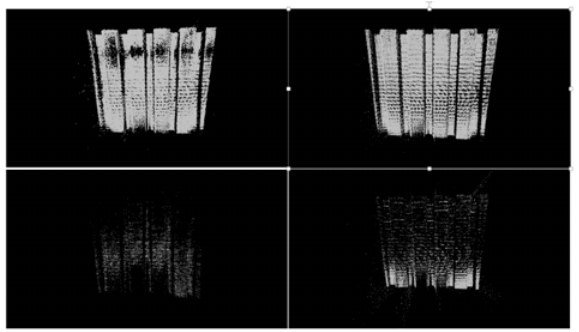
Figure 7: Comparison of point cloud result: conventional gray code (left-top), maximum min-SW gray code (right-top), micro phase shifting code with frequency band around 16 pixels and 5 frequencies (left-bottom), micro phase shifting code with fre- quency bande around 64 pixels and 5 frequencies (right-bottom) The mesh result of the beam is shown in Figure 8. The compari- son of the mesh results between our method and maximum min- SW gray code method are shown in Figure 9. We can see that the surface obtained from our method is much smoother, which shows outperformance over maximum min-SW method, as well as the phase shifting method.